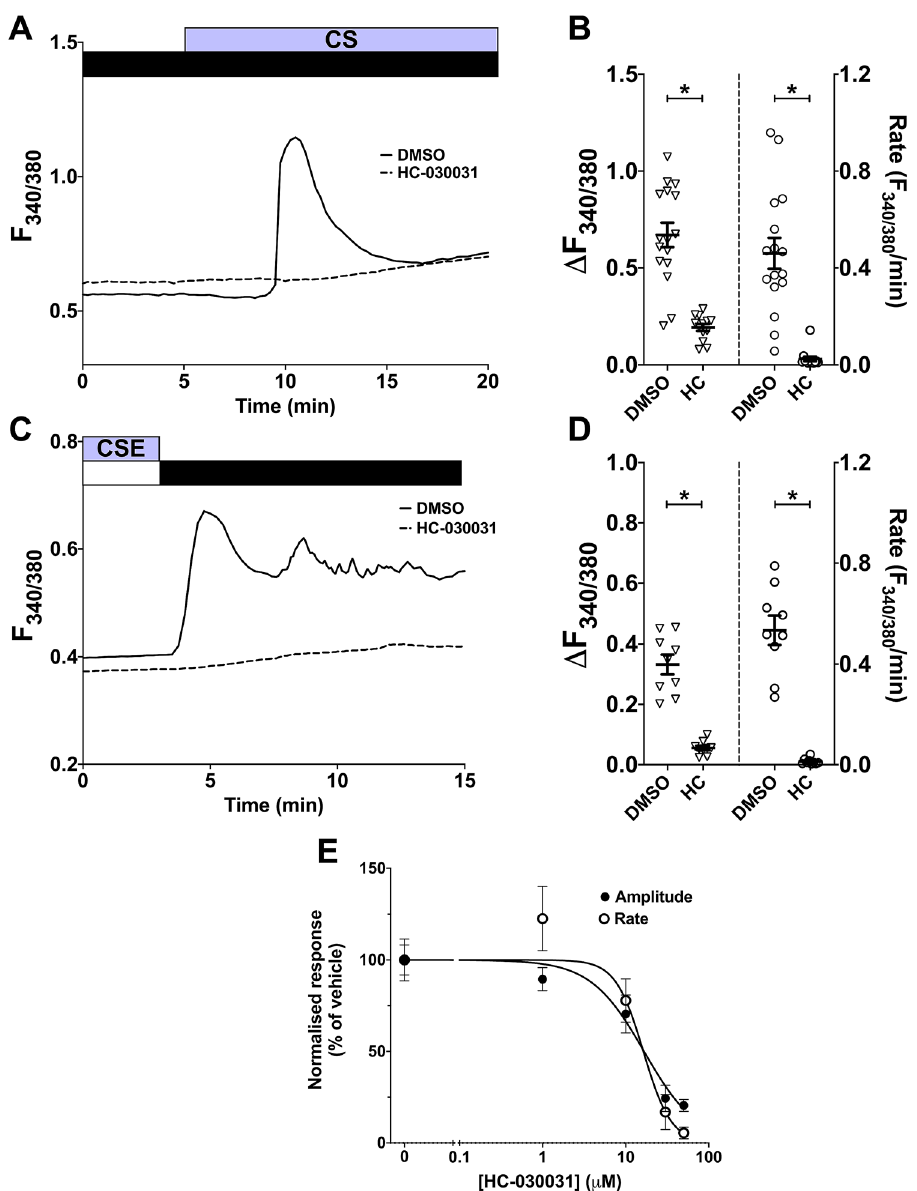
Figure 5. CS and CSE-induced Ca 2+ influx is inhibited by the TRPA1 channel blocker HC-030031 in a concentration-dependent manner. (A,C) Representative Ca 2+ imaging traces from separate experiments tracking changes in [Ca 2+ ] i following puffing one whole cigarette (A) or following Ca 2+ addback after 5-min perfusion with 10% CSE (C) with or without 10-min pre-treatment with 50 µM HC-030031, which was also present throughout the experiment. Equal volumes of DMSO (0.1%) were used for vehicle control. (B,D) Summary of amplitude and rate of the [Ca 2+ ] i increase induced by CS (B) or CSE-activated Ca 2+ addback (D) , respectively, presented as mean ± SEM. Unpaired t-test was performed between the vehicle control group and the HC-030031-treated group (3 independent donors; n = 9–16). * p < 0.05. (E) Dose–response curves for the normalised amplitude and rate of CS-induced Ca 2+ influx (normalised to % of the mean amplitude/rate of DMSO control) at different concentrations of HC-030031, presented as mean ±